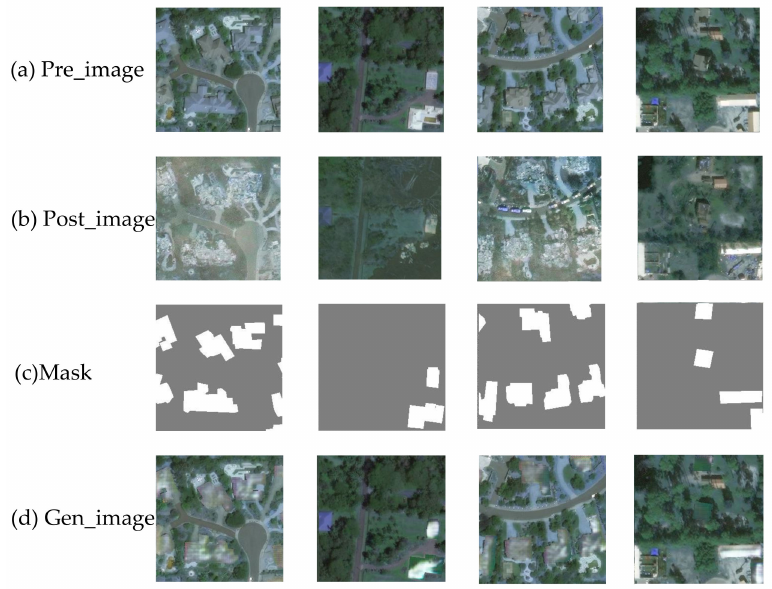
Figure 7. Damaged building generation results. ( a – d ) represent the pre-disaster, post-disaster images, mask, and generated images, respectively. Each column is a pair of images, and here are four pairs of